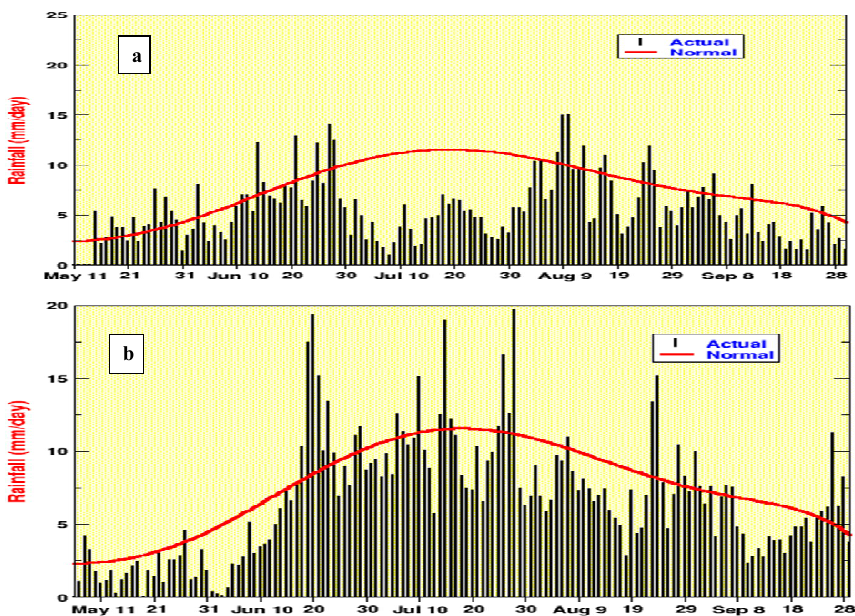
Fig (3): Time series of daily precipitation for India as whole for monsoon 2002 (upper Panel) and monsoon 2003 (lower panel). Solid curve represents daily normal (1951–2000) smoothed values.